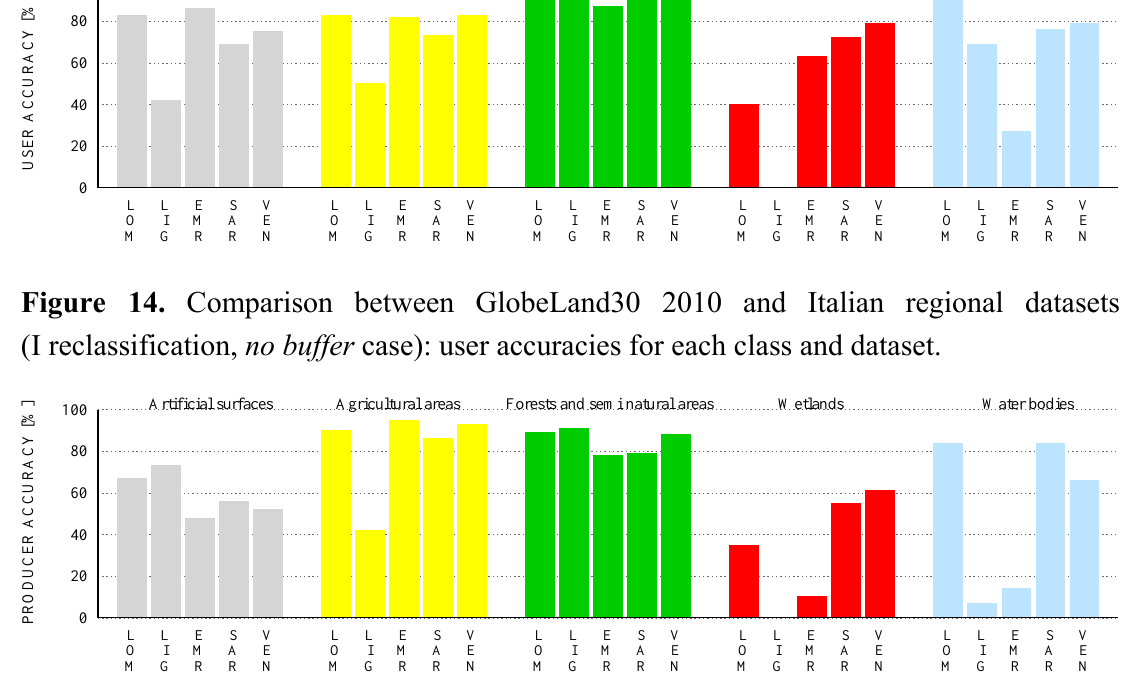
Figure 15. Comparison between GlobeLand30 2010 and Italian regional datasets (I reclassification, no buffer case): producer accuracies for each class and dataset. With respect to the sub-classes, forests is the best detected class with UA and PA values higher than 75% in most cases.